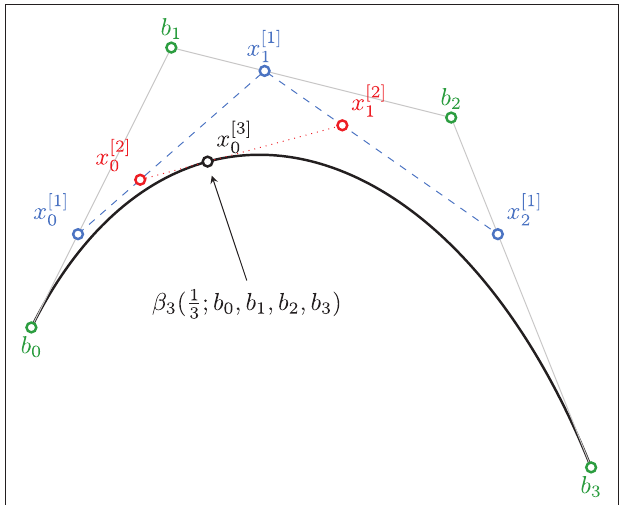
FIGURE 3 | A composite cubic Bézier curve B : [0,3] p i , i 0, ... ,3, (cyan) and intermediate points b ± i (green) determine its shape; = continuous differentiability is illustrated by the logarithmic maps log p i 1,2 (blue ∈ { }